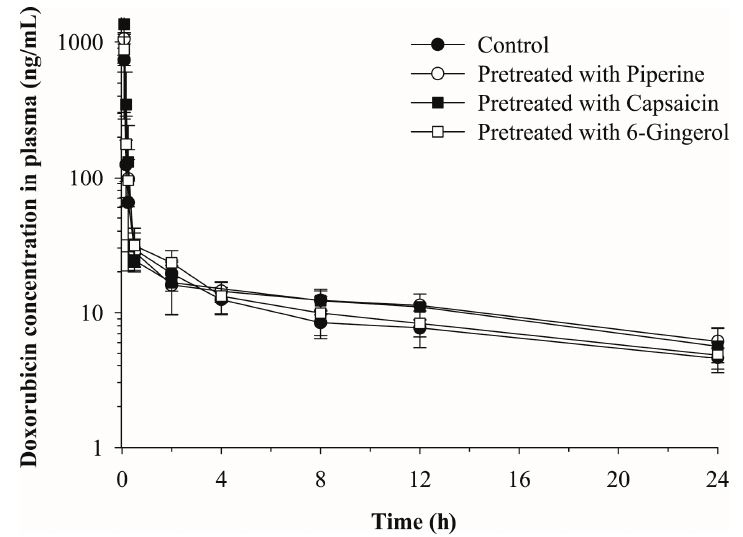
Figure 3. Plasma concentration vs. time profiles of doxorubicin after intravenous injection of doxorubicin at 1 mg/kg in mice pretreated with vehicle (control), piperine, capsaicin, or [6]-gingerol ( n = 6, mean ± SD). Table 3. Average pharmacokinetic parameters of doxorubicin after intravenous injection at 1 mg/kg in mice pretreated with phytochemical P-gp modulators.